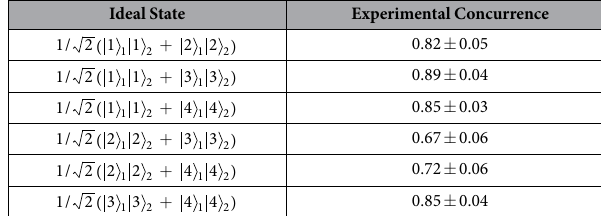
Ideal State Experimental Concurrence